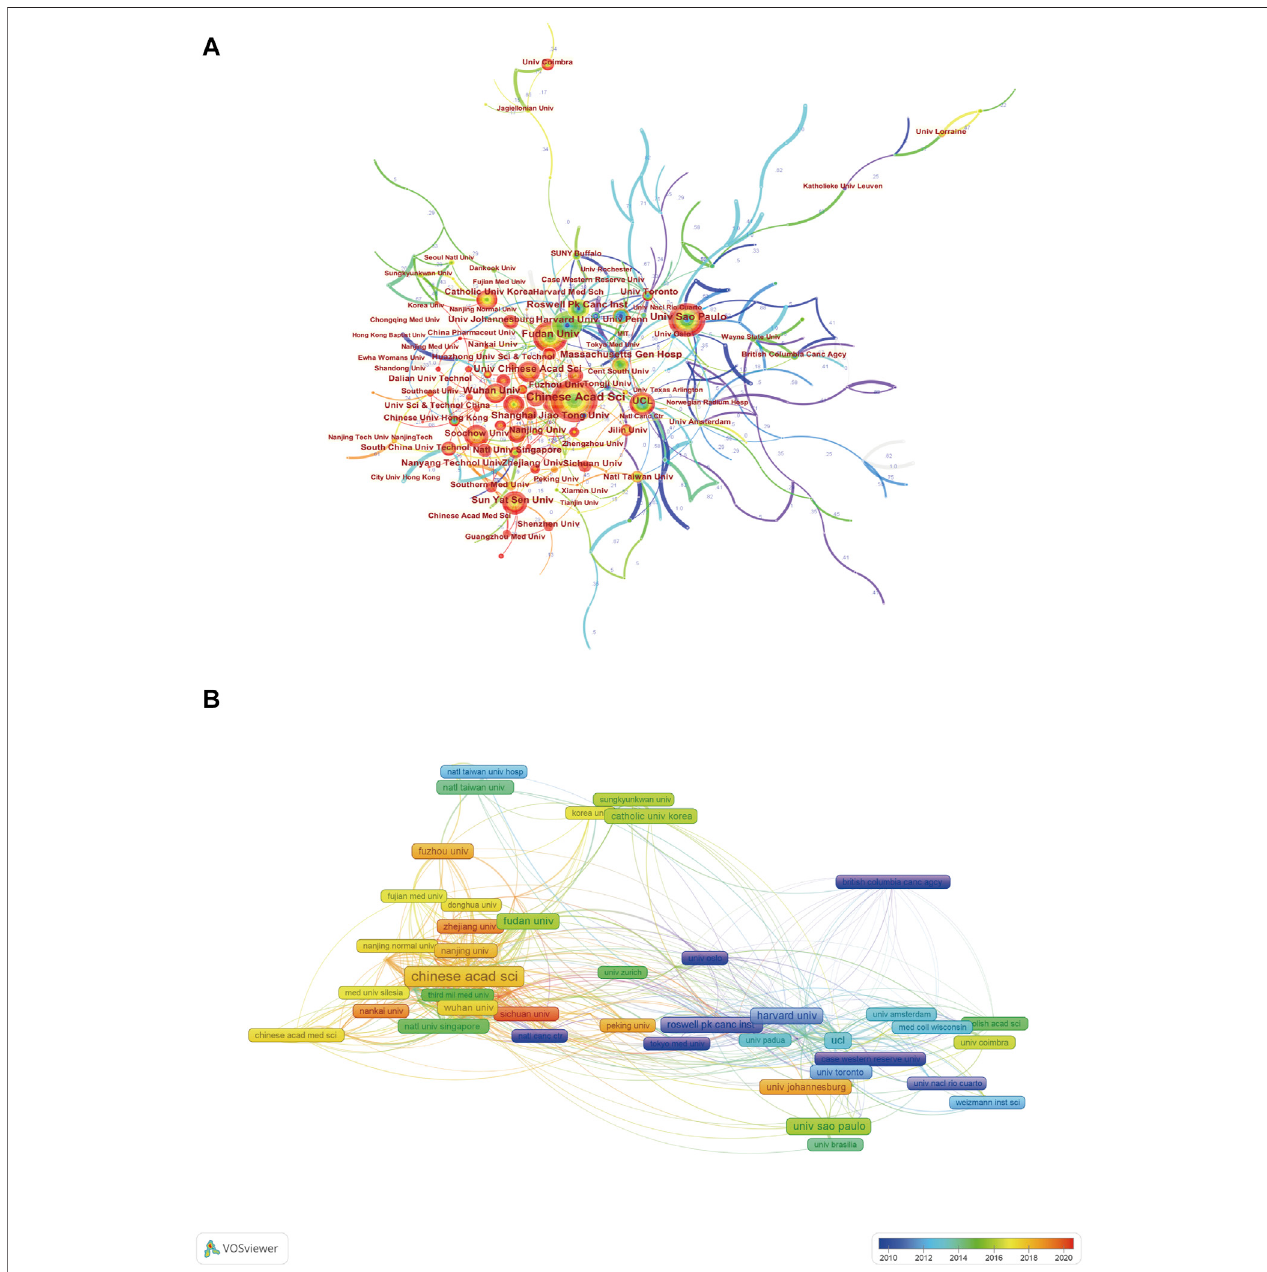
FIGURE 4 | (A) Institutional collaboration analysis by CiteSpace. (B) Institution co-authorship analysis by VOSviewer.